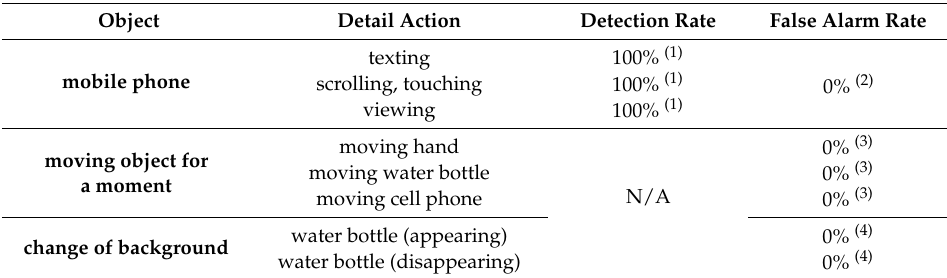
Table 4. Mobile phone detection